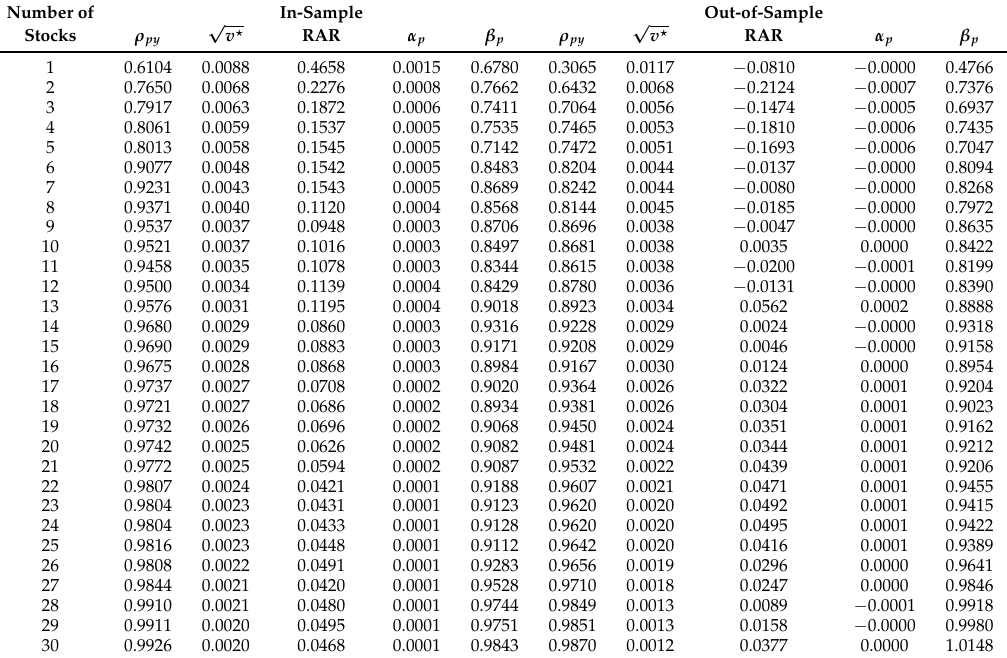
Table 6. Optimal tracking portfolios for DJIA index: Algorithm